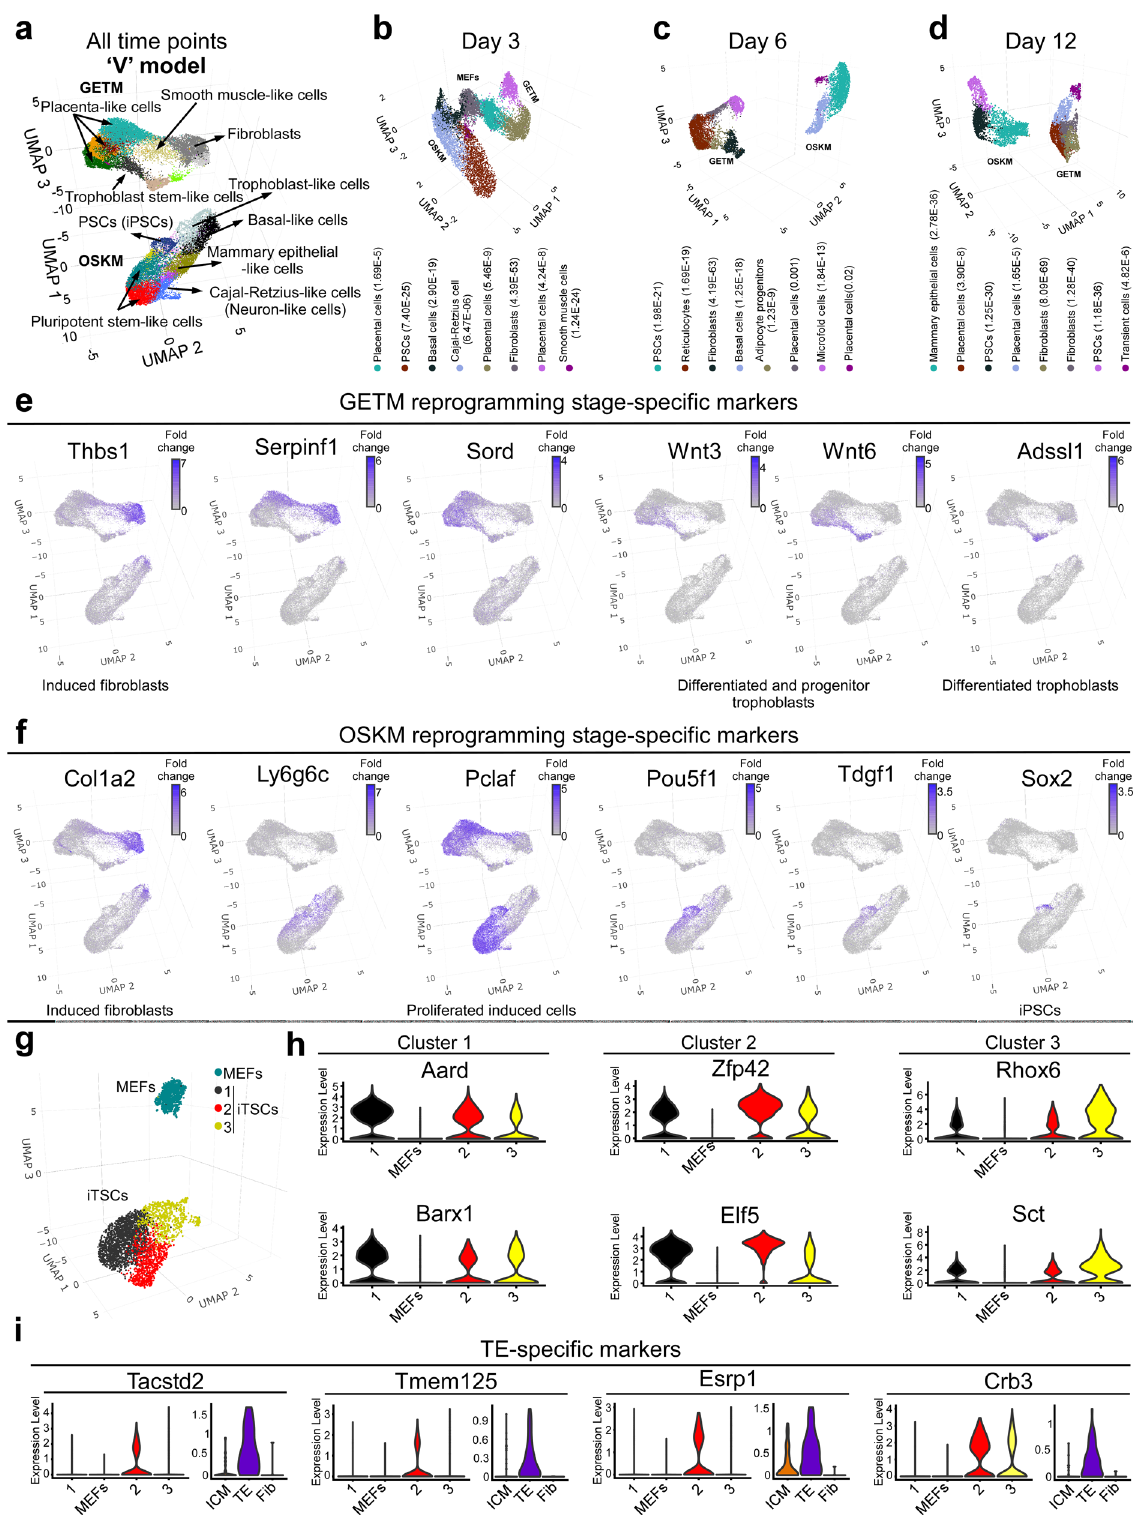
different timepoints (Supplementary Fig. 1d), and parental fi broblasts, bdTSCs, iTSCs, ESCs, and iPSCs, were subjected to RRBS. We used the K-means algorithm to classify ~130,000 genomic regions (blocks) shared amongst all samples during reprogram- ming to a TSC or pluripotent state, and generated 100 unique clusters, some containing tiles that are speci fi c to TSCs and ESCs,